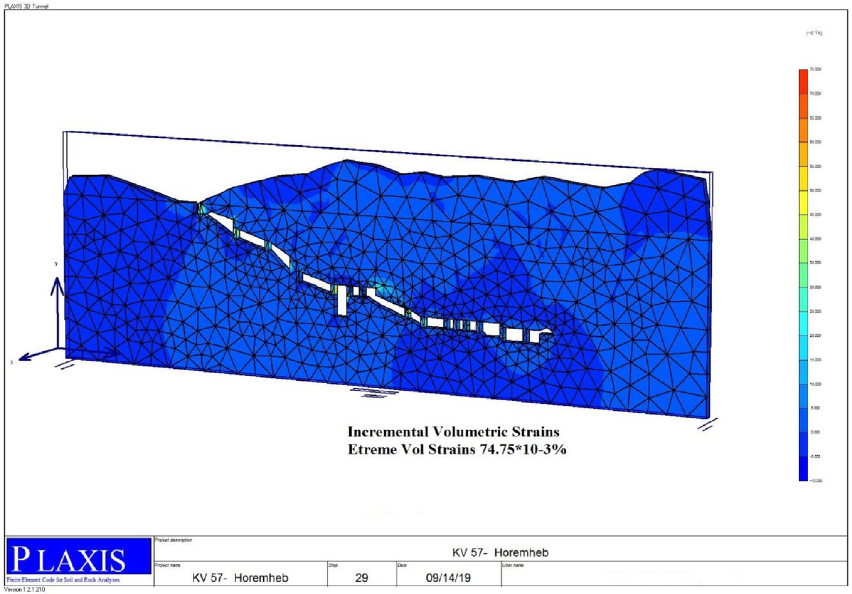
Fig. 8. Incremental Volumetric Strains, the extreme value is 74.75